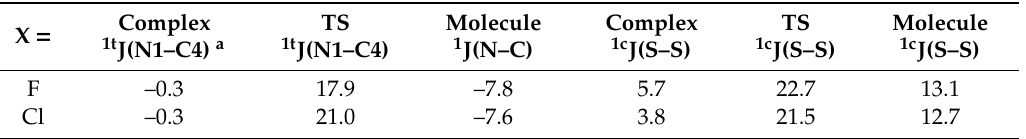
Table 6. Spin-spin coupling constants (Hz) for the HN(CH)SF:SCO and HN(CH)SCl:SCO complexes, transition structures, and molecules a .